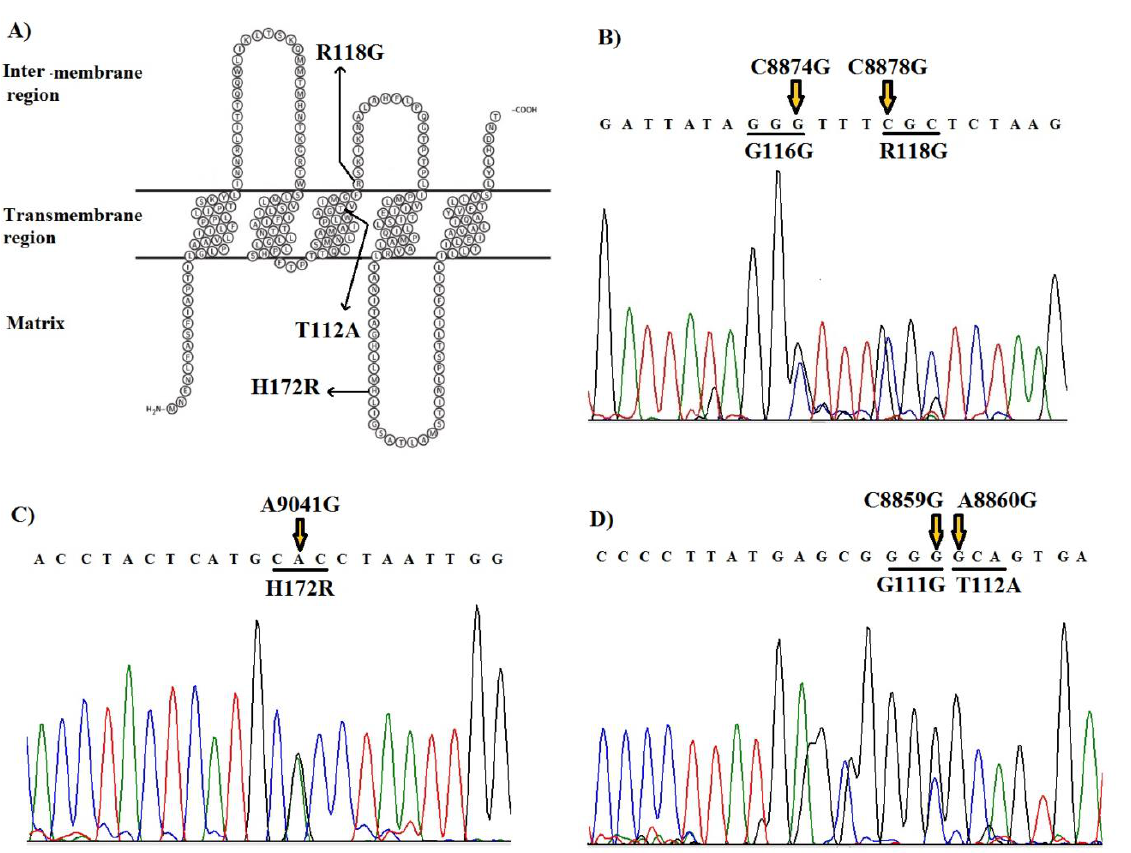
Figure 7: A ) The position of three missense mutations (Thr112Ala, Arg118Gly, and His172Arg) and changes of related amino acids in the secondary structure of the ATPase6 protein, B, C, and D ) Se- quencing results of three heterozygous missense variations in ATPase6 gene in CHD patients. Two patients with VSD symptoms showed two nucleotide variations in the ATPase6 gene, simultaneously: C8859G (Gly111Gly) and A8860G (Thr112Ala) variations in a 1.5-years-old girl, and C8874G (Gly116Gly) and C8878G (Arg118Gly) variations in a 6-months-old